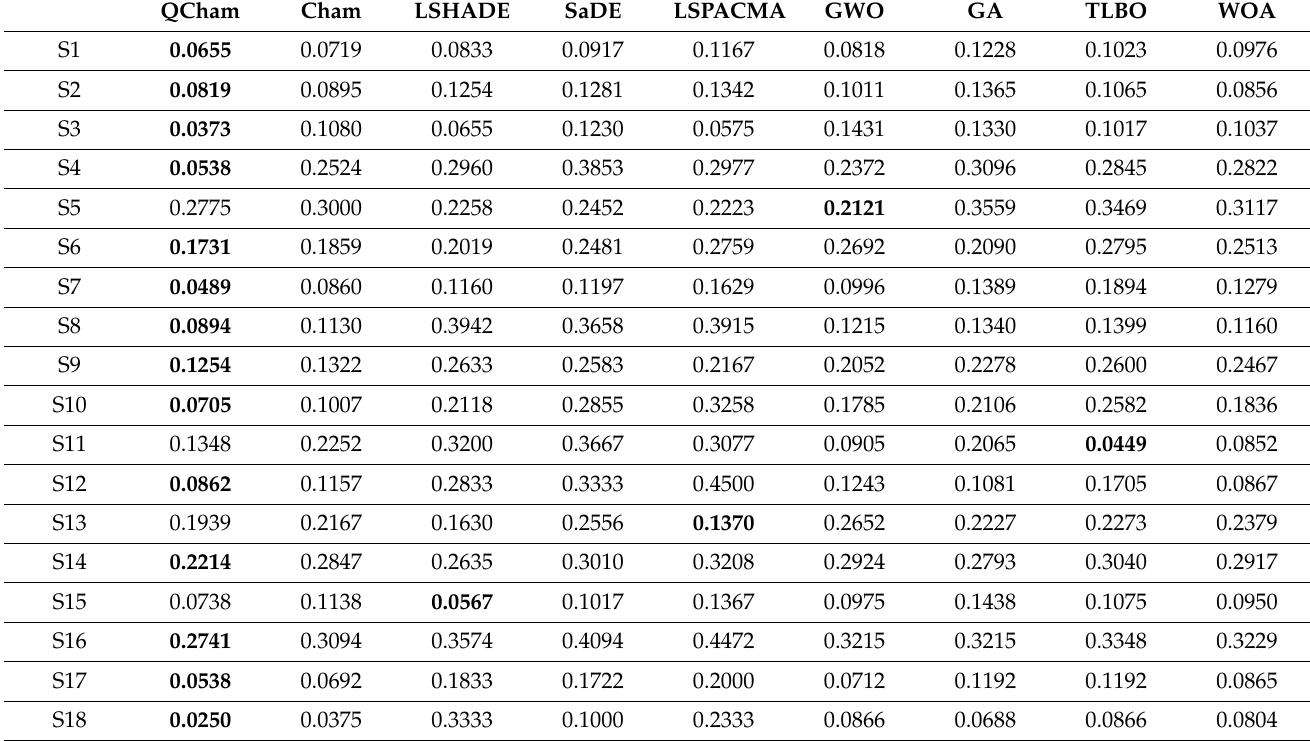
Table 5. Worst fitness values for QCham and others.